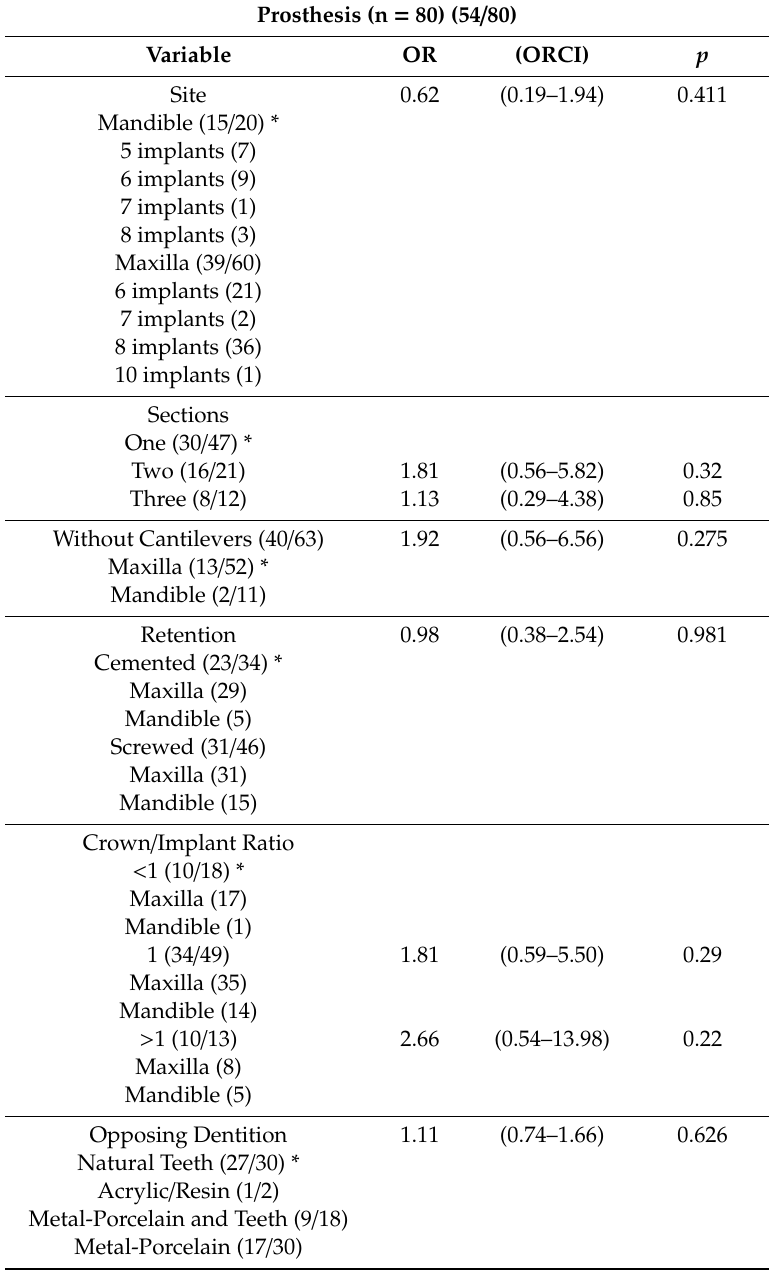
Table 2. Distribution of mucositis complications in the sample in relation to prosthesis based